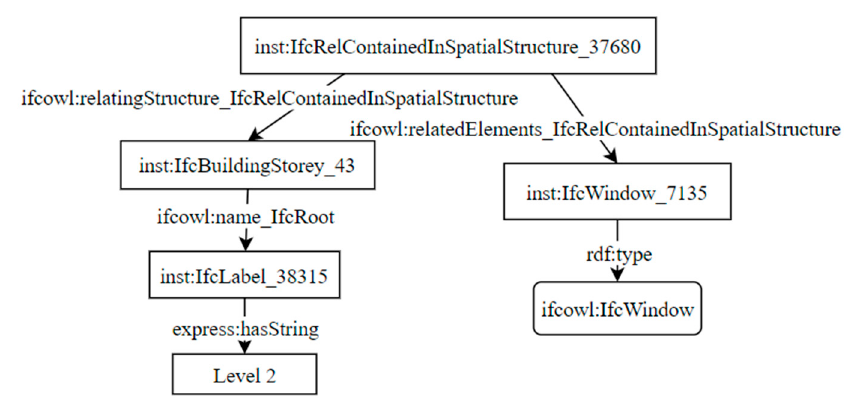
Figure 7. The shortest path connecting the two keywords.